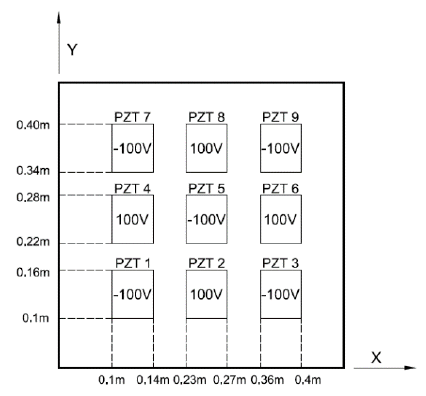
Figure 15. Distributed PZT actuators arranged in a 3 × 3 array surface bonded on a composite laminate.